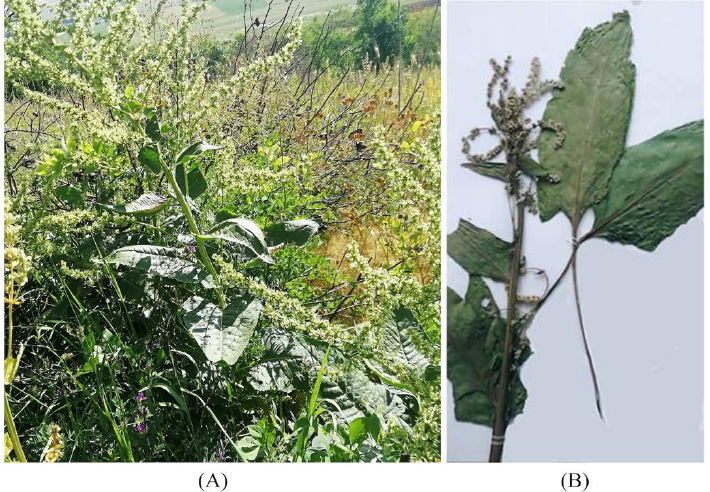
Figure 4. Beta corolliflora species in their natural habitat ( A ) and a herbarium specimen ( B ). Hrazdan town (1675 m a.s.l.), Kotayk marz, RA, 20 July 2019.